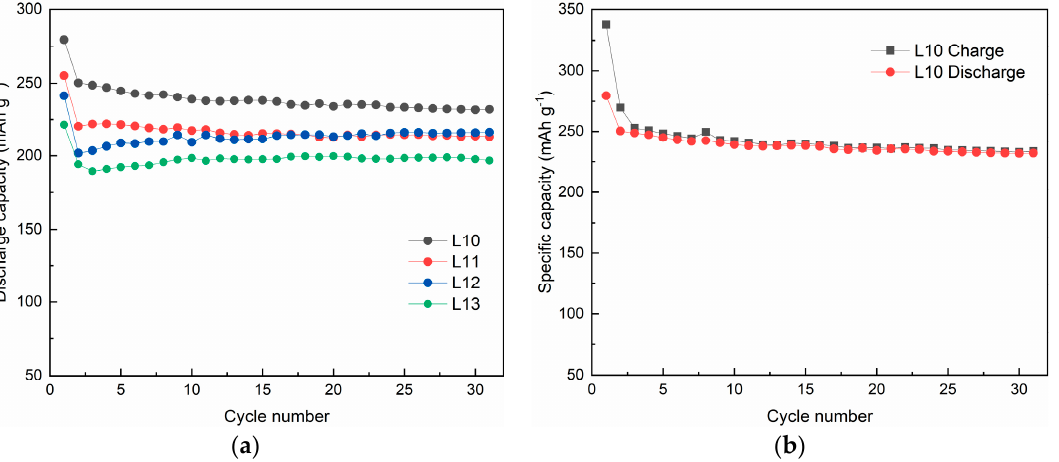
Figure 4. ( a ) Cycling performance of samples L10–L13 for 30 cycles in the range of 2.0–4.8 V; ( b ) Charge–discharge curves of sample L10 for 30 cycles in the range of 2.0–4.8